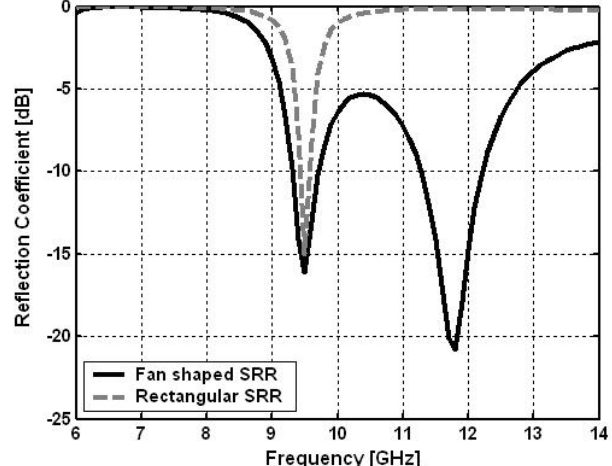
Figure 3: The simulated reflection coefficient of rectangular SRR and fan shaped SRR metamaterial absorber for co- polarized